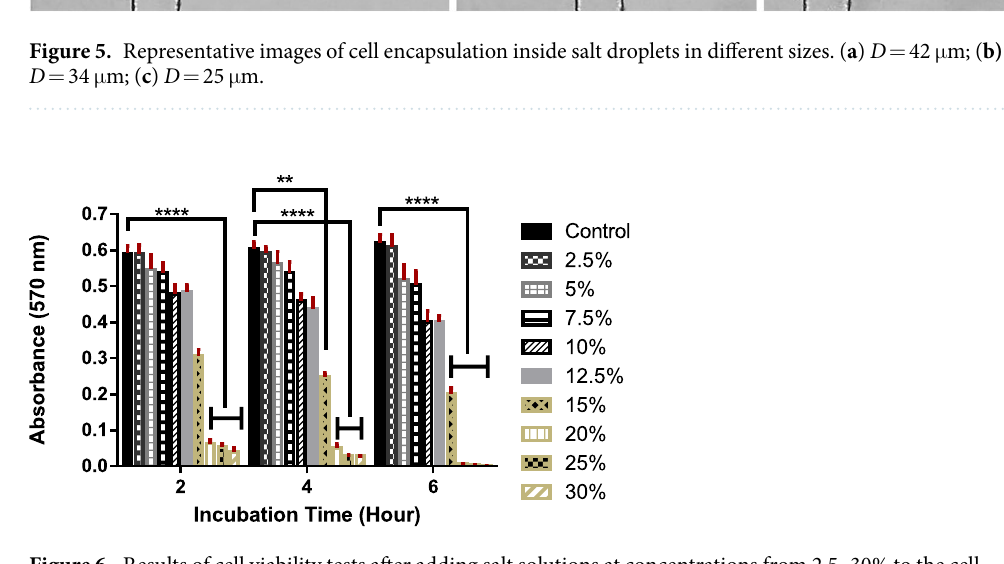
Figure 6. Results of cell viability tests after adding salt solutions at concentrations from 2.5–30% to the cell suspension. MTT assay shows the intensity of absorbance with cell treated time for nine different groups (n =